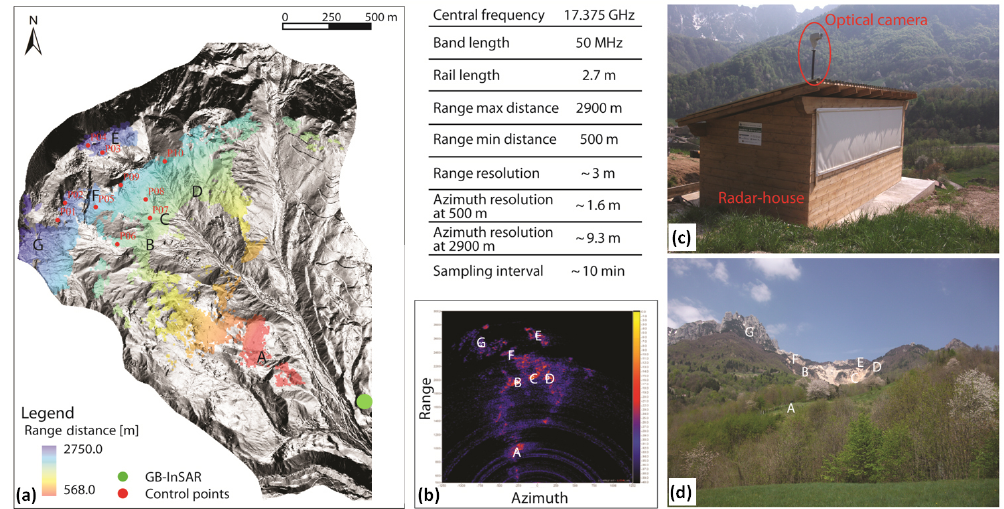
Figure 5. The adopted monitoring system: (a) location of the GB-InSAR system and radar data coverage features (A–G are recognized landslide sectors); (b) the adopted monitoring parameters and radar power image, displaying the correspondent recognized landslide sectors; (c) the radar system hut setting; (d) picture of the monitoring optical system scenario (A–G are corresponding